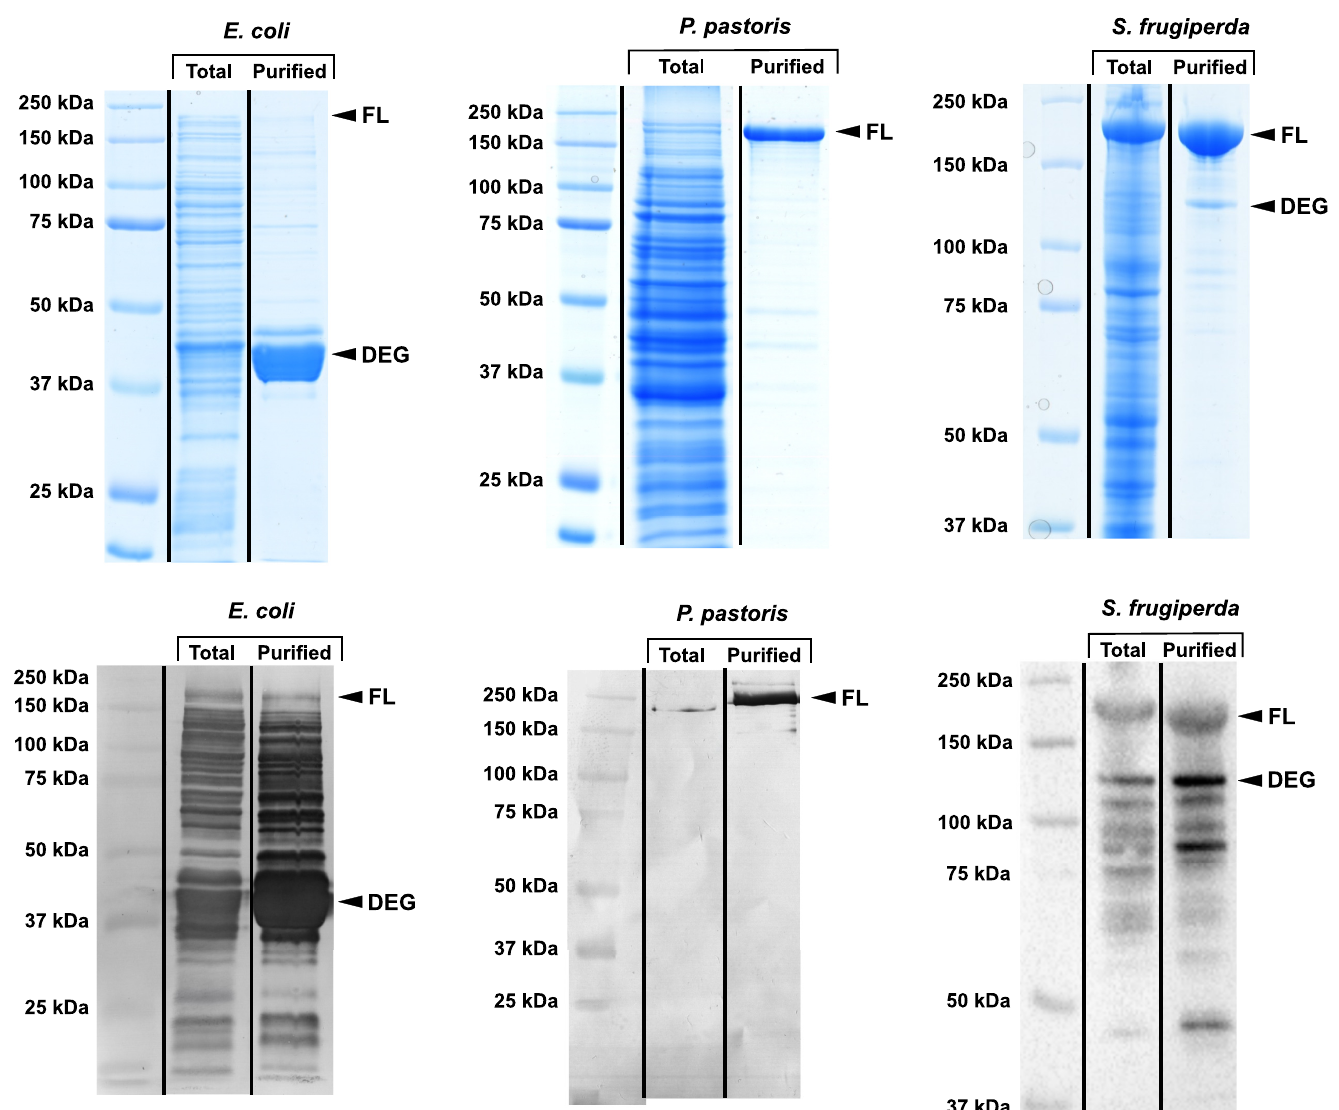
Fig 4. ROCK2 expression and purification in various hosts. To test the pONE vector set we have used it for the expression screening of a large, multi-domain human protein, the ROCK2 kinase. ROCK2 was expressed in the bacterium E . coli , the yeast P . pastoris and the insect cell S . frugiperda using the intracellular vectors pONE-10K, pONE25-A and pONE30-A, respectively. Cells were lysed and ROCK2 purified from the lysate by amylose affinity chromatography. Samples were taken during the process, and analysed by SDS PAGE and Western blotting using anti-MBP antibody (upper and lower images, respectively). As for the evaluation of the results, it is notable that impurities are generally more visible on Western blots due to its greater sensitivity and non-linearity compared to Coomassie staining. Each image presents the total protein content after expression (‘Total’) and the purified protein after the affinity chromatography (‘Purified’). Bands corresponding to full- length ROCK2 (‘FL’, M w ~206 kDa with the fusion MBP tag) and the main degradation product (‘DEG’) are marked. E . coli is not suitable for ROCK2 expression, as the amount of full-length protein expressed is negligible compared to the degradation products, likely due to folding problems. In this host, the ROCK2 segment (M w ~161 kDa) of the fusion protein degrades almost completely, while MBP (M w ~45 kDa) remains intact, probably protected by its correct fold. In eukaryotic hosts, however, the bulk of ROCK2 is expressed as its full-length form. ROCK2 expressed in P . pastoris proved to be at least as pure as that expressed in S . frugiperda , the most commonly used host for ROCK2 expression. In fact, the presence of degradation products appears to be lower than in insect cells. However, both in P . pastoris and S . frugiperda a small amount of impurities appear along with the purified protein. Based on the Western blots, these are host proteins in the case of P . pastoris , and degradation products of ROCK2 in the case of S . frugiperda . In insect cells the degradation product is probably a fragmented MBP-ROCK2 fusion protein, where the C-terminal domain(s) of ROCK2 are cleaved off. It is demonstrated that yeast can effectively substitute insect cell culture for the expression of large, complex, multi- domain